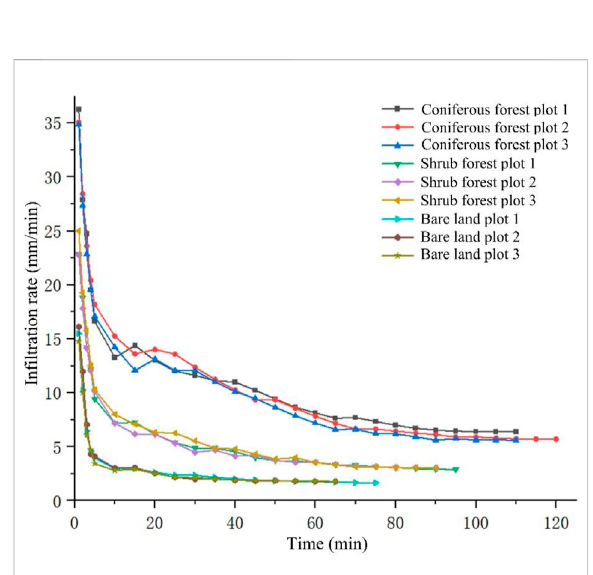
FIGURE 4 Divisions of the slope unit in the study